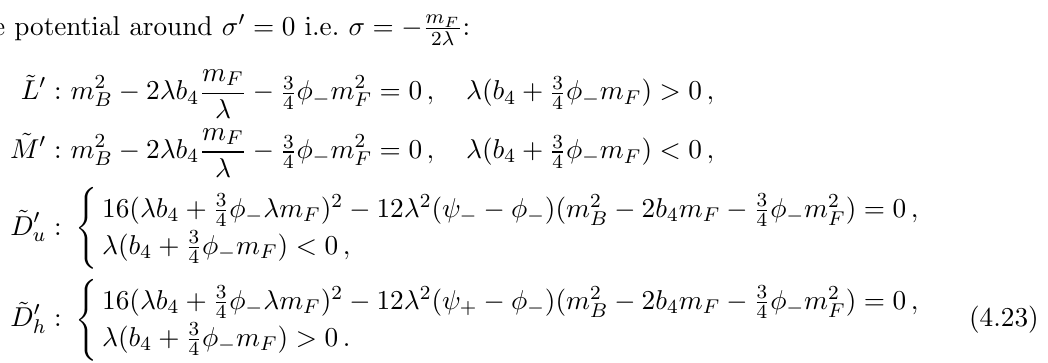
Figure 10. The m F = (cid:0)j (cid:22) j sgn( (cid:21) ) section of the surfaces in (4.15) and (4.16) for j (cid:21) j < 1 of the inset pair-of-plots in (cid:12)gure (a) correspond to the pro(cid:12)les of the potential ~ U ( (cid:27) ) (the plot on the left) and ~ U 0 ( (cid:27) 0 ) (the plot on the right). The vertical lines in each of these plots correspond to the points (cid:27) = 0 and (cid:27) 0 = 0 respectively. The inset plots in (cid:12)gure (b) are the pro(cid:12)les of the potential (4.19) and the two vertical lines in these plots correspond to (cid:27) = 0 and (cid:27) = (cid:0) m F = 2 (cid:21) respectively. Blue lines correspond to a minimum of the local potential crossing the vertical axis while the red lines correspond to a maximum crossing the vertical axis. The dashed and dotted lines correspond to either the appearance or disappearance of new extrema in the